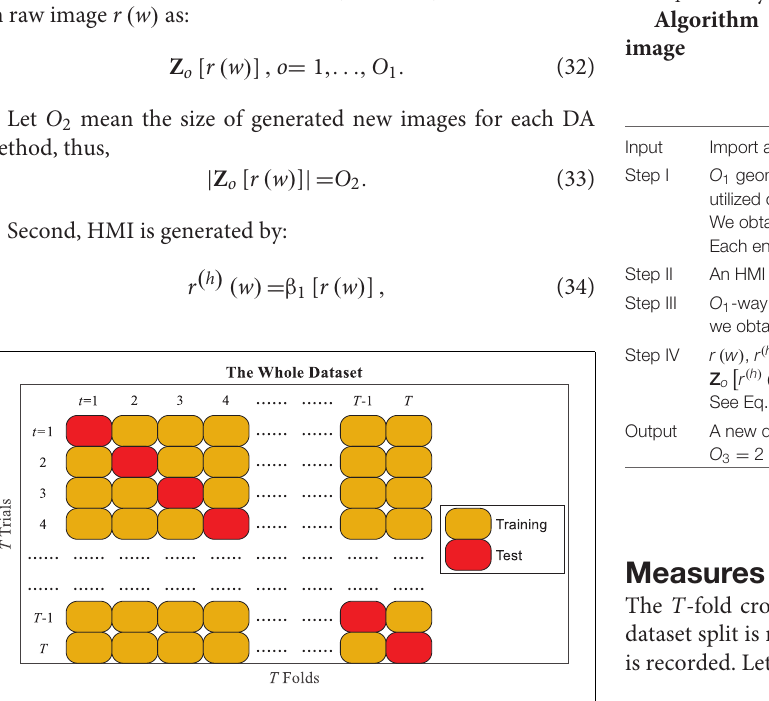
Algorithm 3 recapitulates the pseudocode of 18-way DA. We set O 1 = 9 to yield an 18-way DA. Algorithm 3 Pseudocode of 18-way DA on w-th